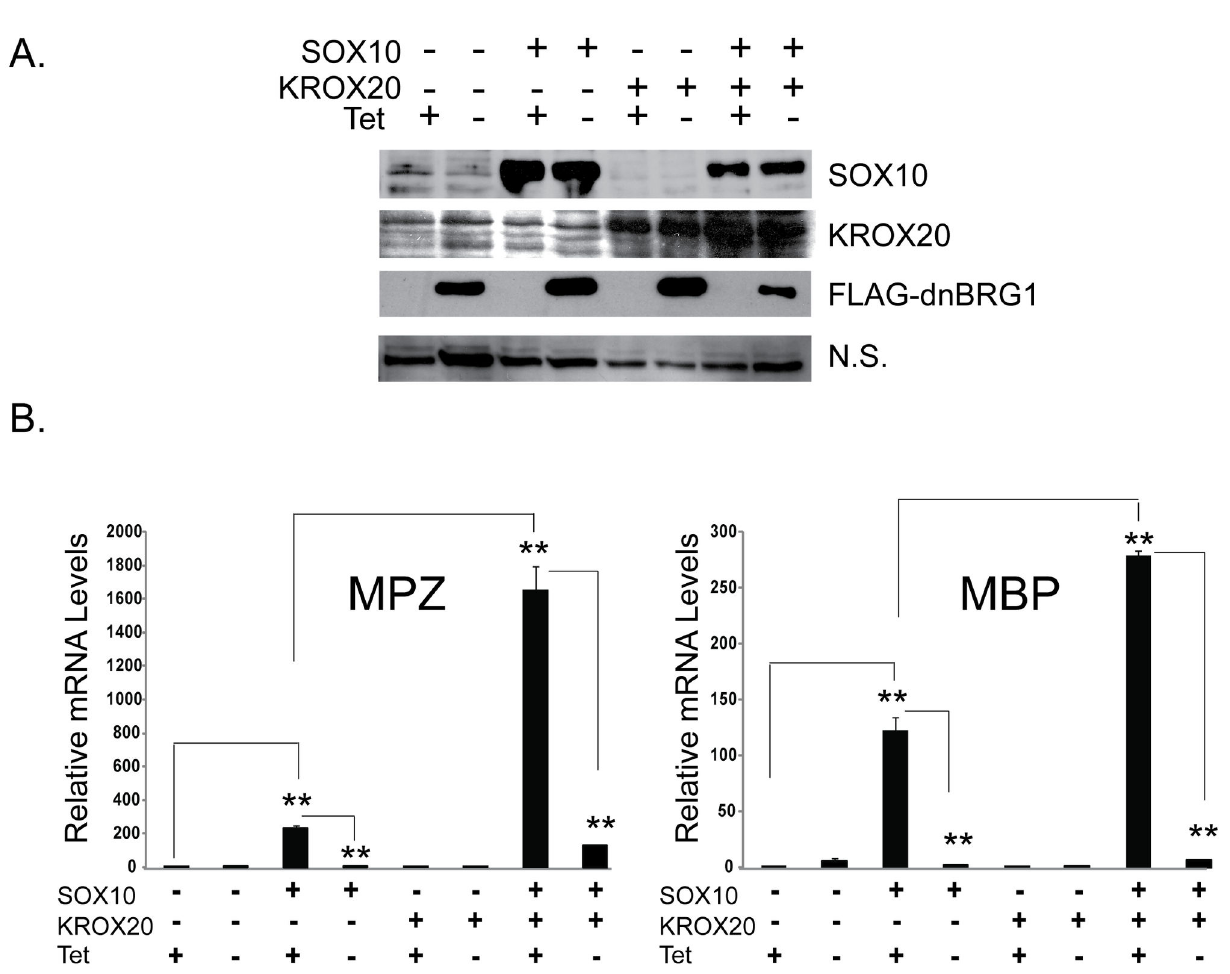
Figure 2. Dominant negative BRG1 inhibits synergistic activation of myelin genes by SOX10 and KROX20. Cell lines that express dominant negative BRG1 were infected with an empty vector, pBabe-SOX10, pBabe-KROX20, or pBabe-SOX10 together with pBabe-KROX20 in the presence or absence of tetracycline and then cultured in low serum media to promote differentiation. (A) Western Blot showing expression of SOX10 and KROX20 in the presence and absence of tetracycline and the expression of FLAG- tagged dominant negative BRG1 in the B22 cell line when cells were cultured in the absence of tetracycline. Protein expression was detected from nuclear extracts and a non-specific band was used as a loading control. (B) Quantitative RT-PCR (qRT-PCR) of SOX10 target genes from pBabe or pBabe-SOX10, pBabe-SOX10, pBabe-KROX20, or pBabe-SOX10 together with pBabe-Krox20 infected cells. Expression of MPZ and MBP was normalized to expression of RPL7. The data are representative of greater than three experiments and are the average of two independent experiments performed in triplicate. Standard error bars and statistical significance are shown